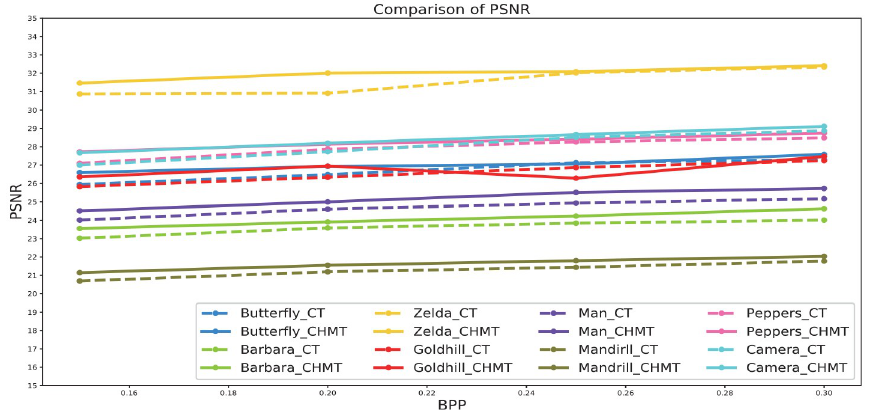
Fig 12. Comparison of PSNR between the contourlet transform and contourlet-HMM–PCNN algorithms.